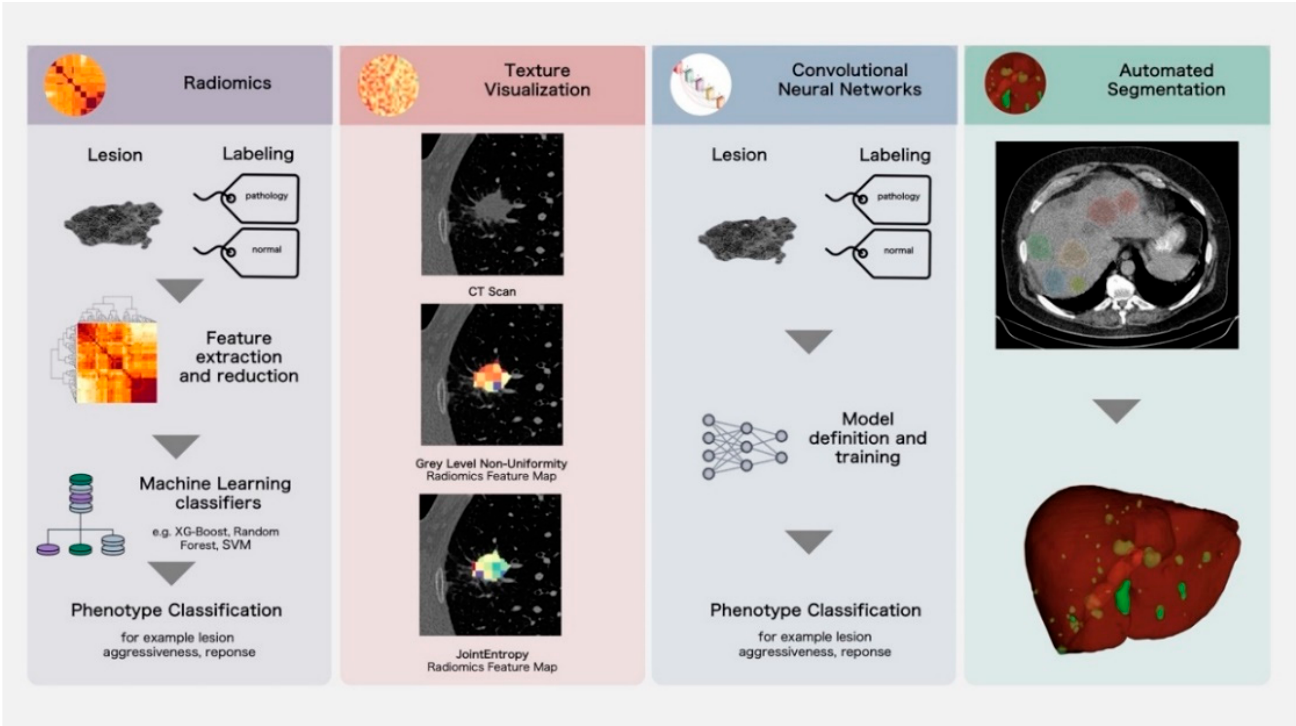
Figure 3. Overview of imaging biomarker methodology.